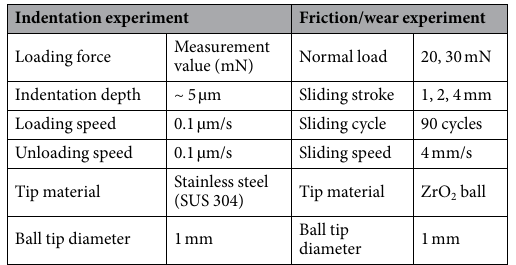
Table 2. Experimental conditions for indentation and friction/wear